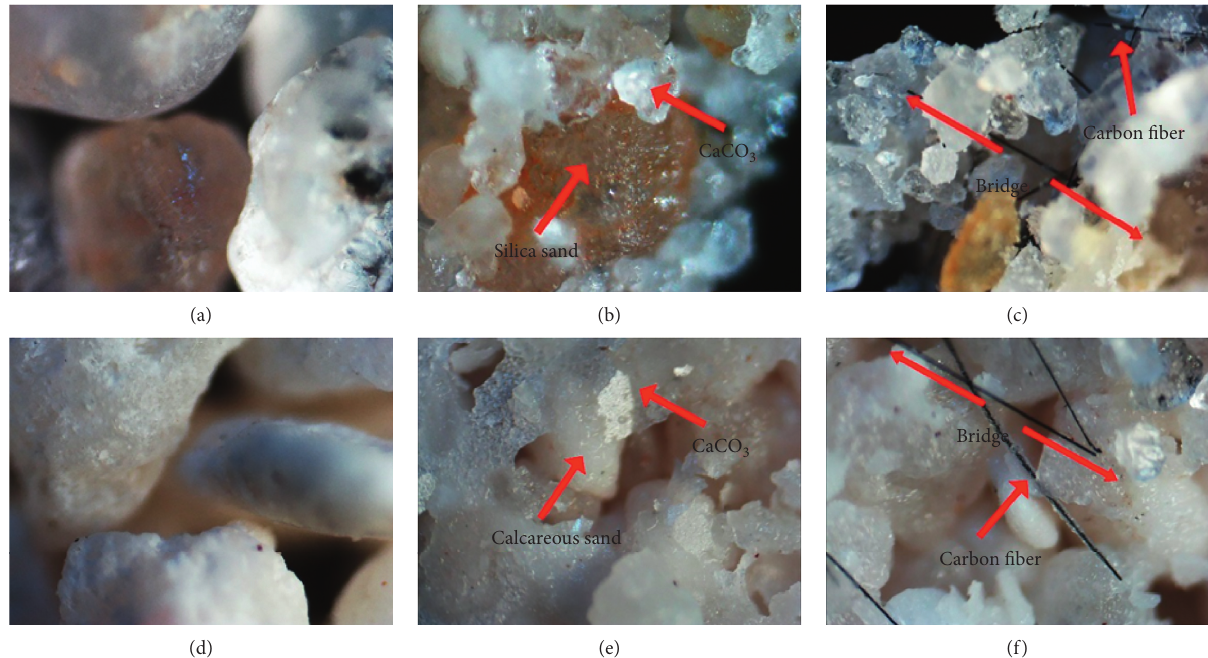
Figure 10: Electron microscope pictures of silica and calcareous sand at different magnification values. (a) Silica sand (100 × ). (b) After MICP (40 × ). (c) Reinforced with fiber (40 × ). (d) Calcareous sand (100 × ). (e) After MICP (40 × ). (f) Reinforced with fiber